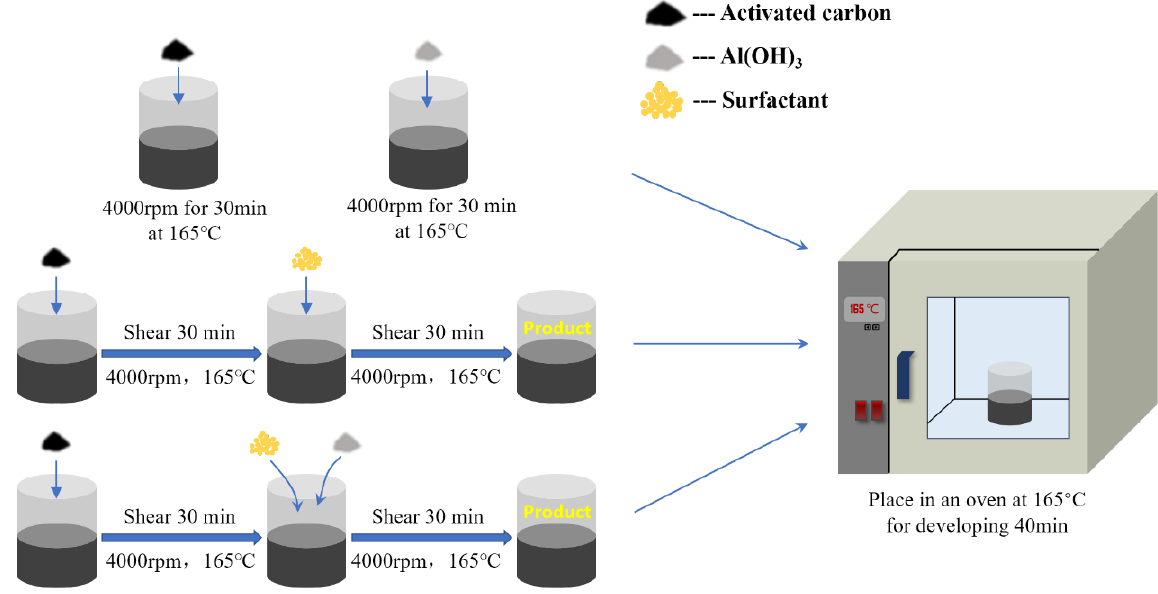
Figure 2. Preparation procedures of environmentally friendly modified asphalt.